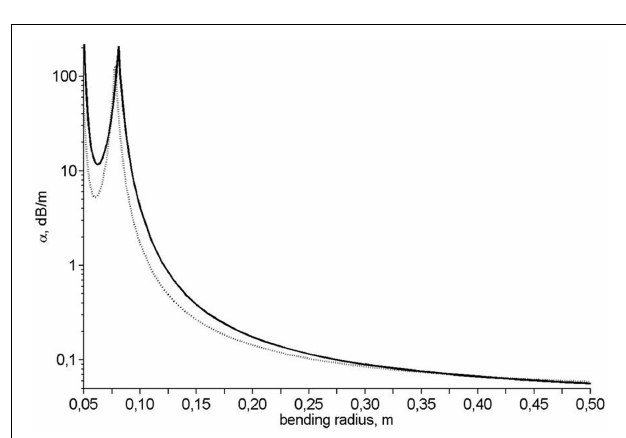
FIGURE 5 | Calculated dependence of the bending losses of the fundamental HE 11 air-core mode on bending radius at λ = 10.3 µ m for As 2 S 3 (dotted line) andAs 30 Se 50 Te 20 (solid line) glasses (Shiryaev et al., 2014b)